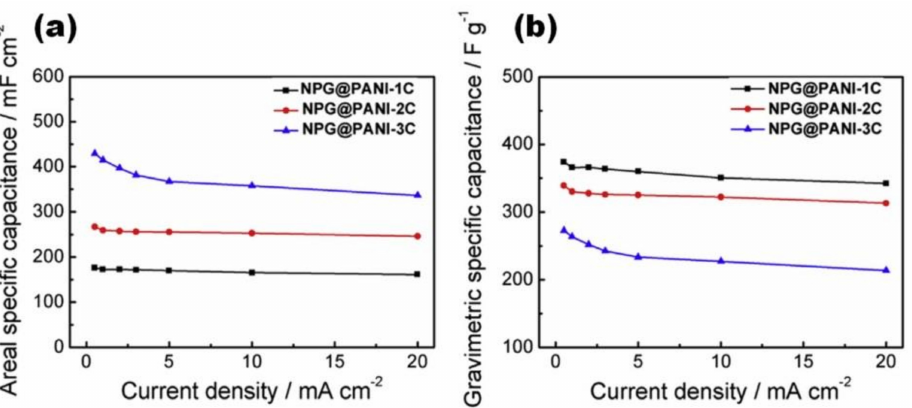
Figure 18. Electrochemical performance of NPG@PANI films with various polymerization charge densities measured by a three-electrode method in 1 M Et 4 NBF 4 -AN electrolyte: areal specific capacitances as a function of various current densities ( a ) and gravimetric specific capacitances as a function of various current densities ( b ) (Reprinted from [47], Copyright 2019, with permission of